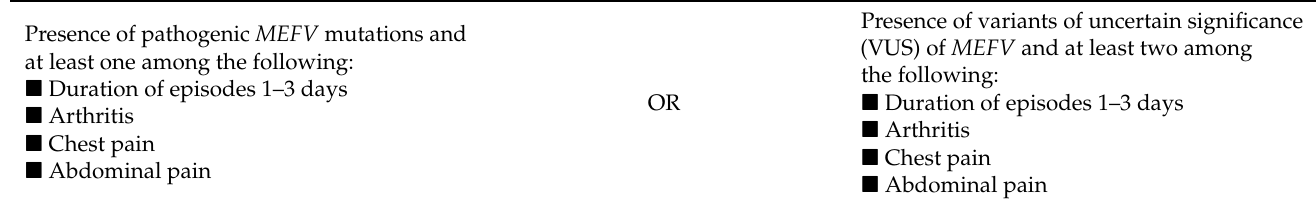
Table 2. New Eurofever/PRINTO Classification Criteria for